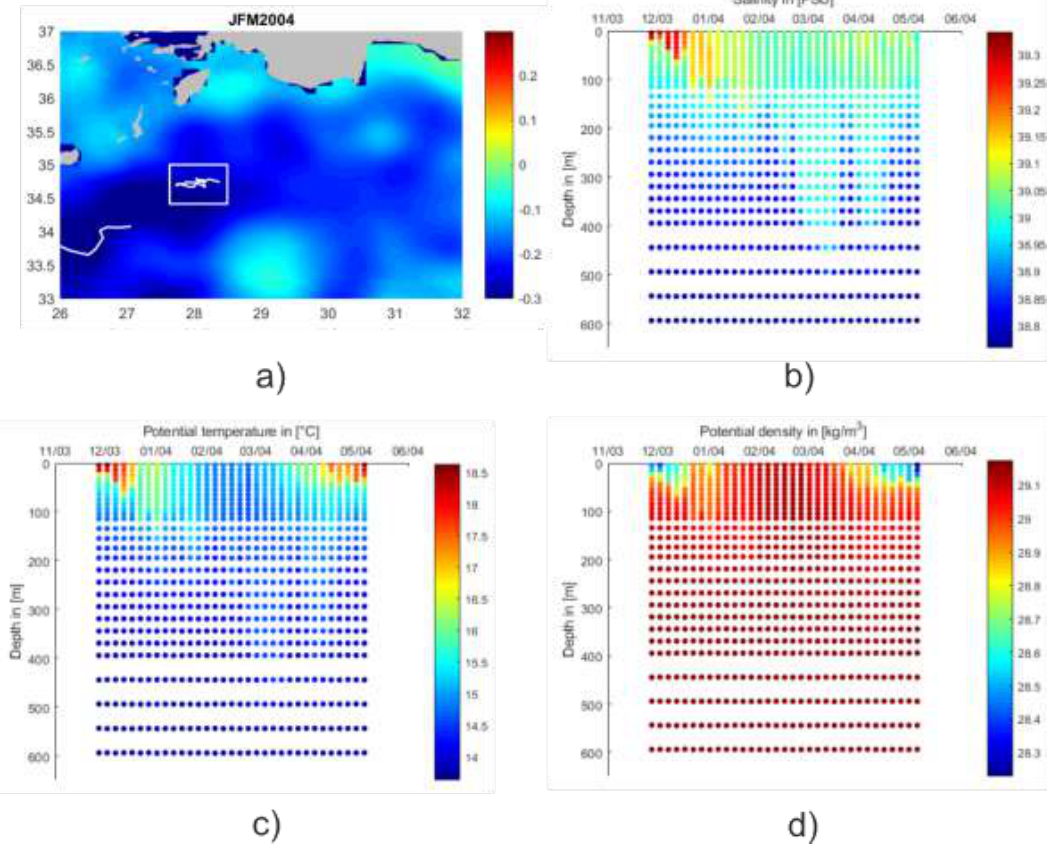
Figure 12. ( a ) Mean SSH (m) of the Northwestern Levantine Sea and float trajectory of float WMO 6900098 for JFM 2004. ( b ) Salinity (PSU), ( c ) potential temperature (°C), and ( d ) potential density (kgm - 3 ) from December 2003 to April 2004.